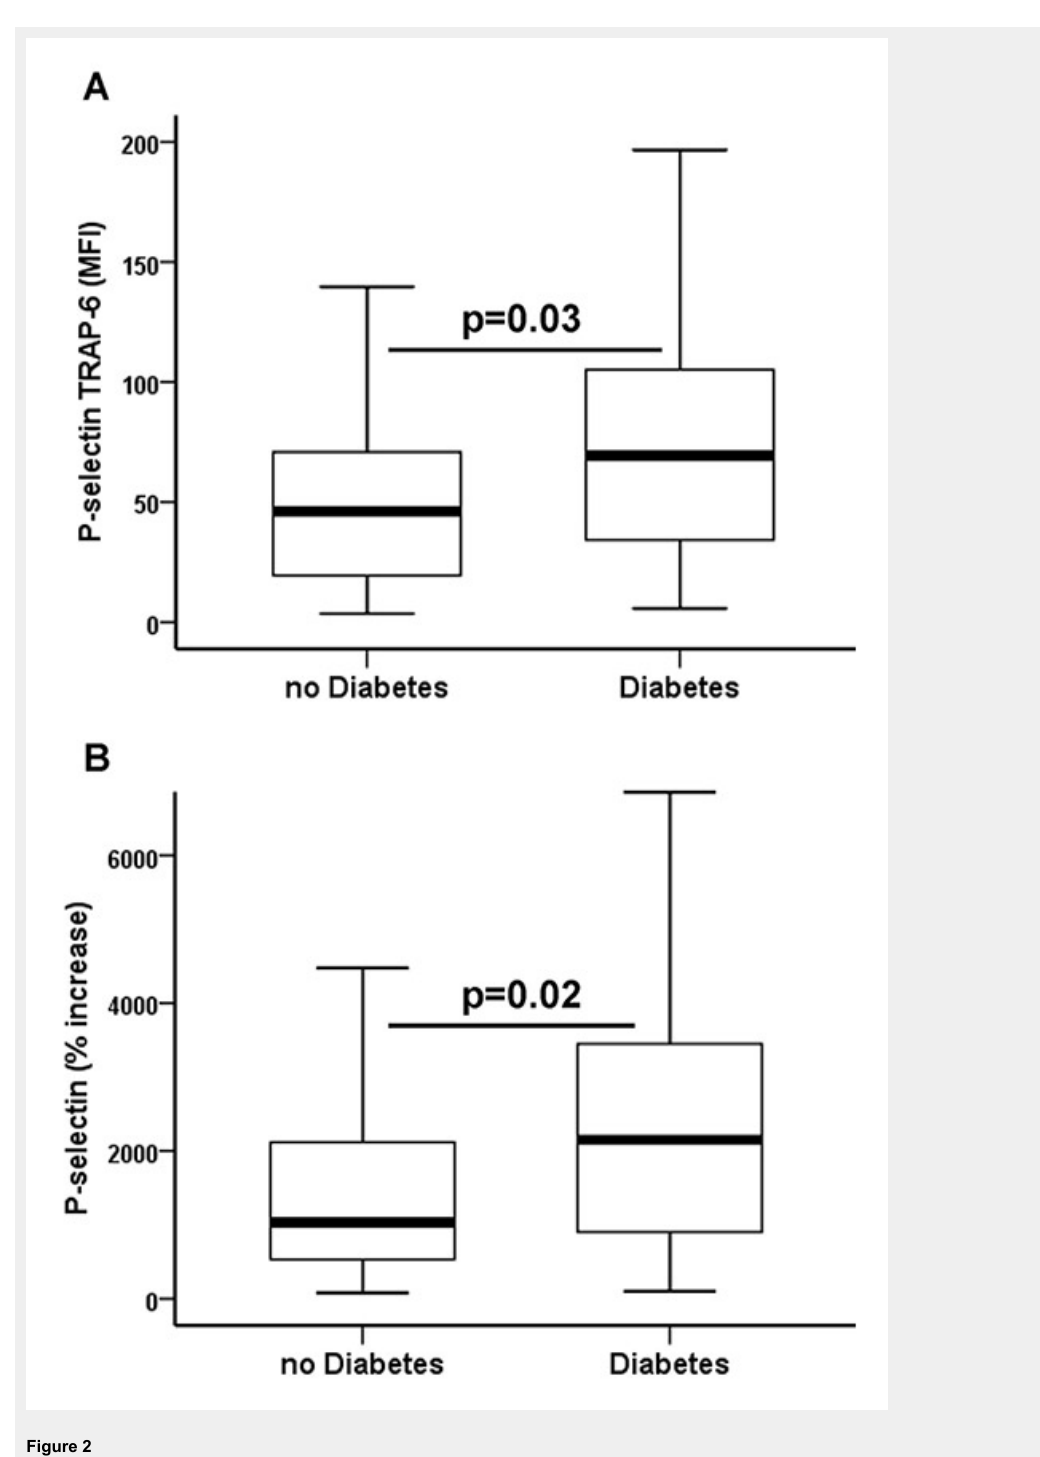
Figure 2 (A) Thrombin receptor activating peptide-6 (TRAP-6) inducible P-selectin (P-selectin TRAP-6) and (B) relative increase of platelet P-selectin (% increase) after activation with TRAP-6 in patients with coronary artery disease without and with type 2 diabetes. The boundaries of the box show the lower and upper quartiles of data, the line inside the box represents the median. Whiskers are drawn from the edge of the box to the highest and lowest values that are outside the box but within 1.5 times the box length. MFI = mean fluorescence